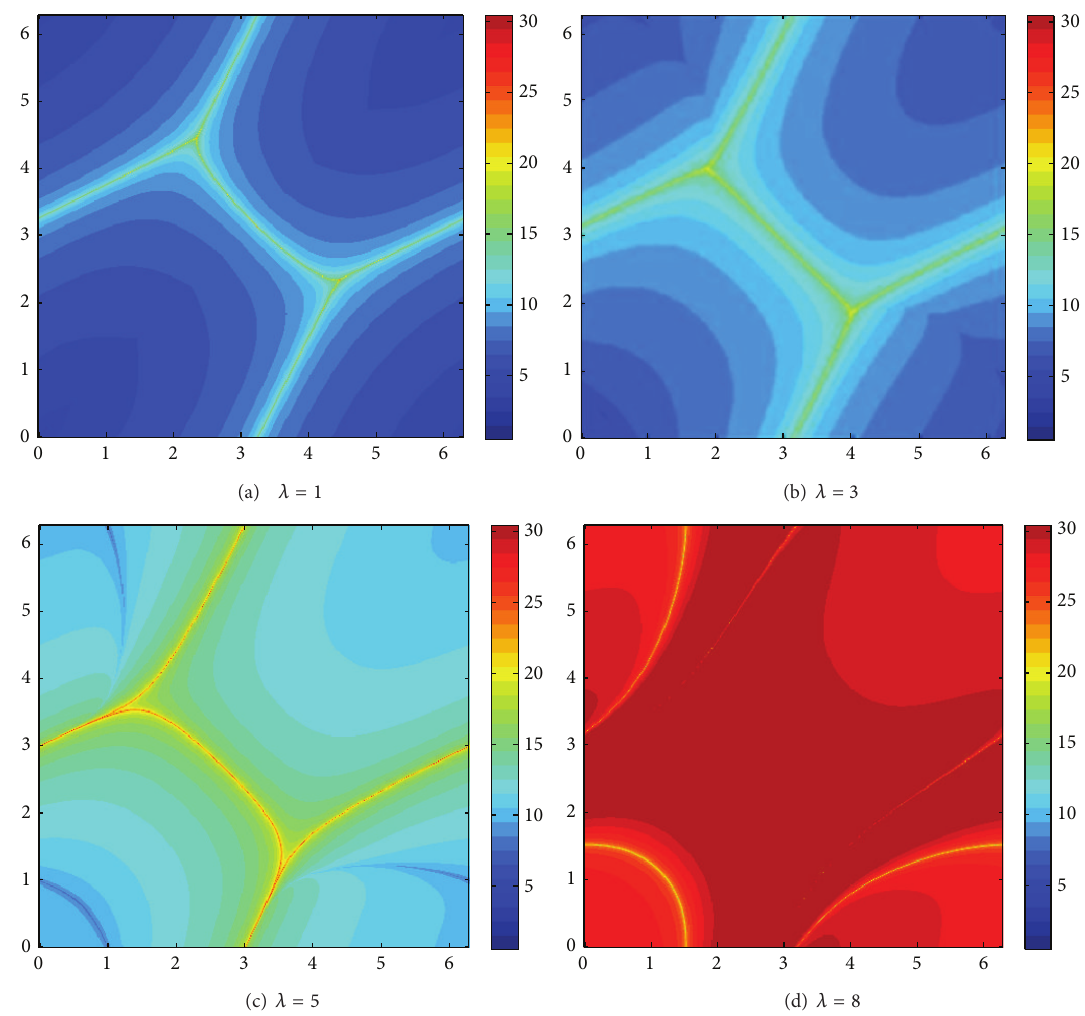
Figure 10: The convergence region and the number of iterations needed for the FDPF method to converge at different loading conditions on ( 𝜃 2 ,𝜃 3 ) plane: (a) the lightly loaded condition, 𝜆 = 1 ; (b) 𝜆 = 3 ; (c) 𝜆 = 5 ; (d) the heavily loaded condition, 𝜆 = 8 . From an initial condition, the number of iterations required by the FDPF method increases with the increase of loading